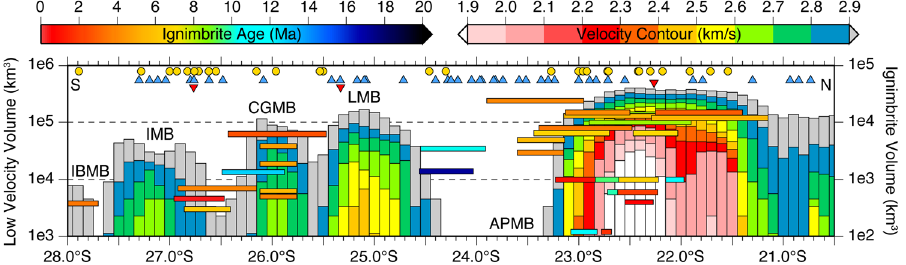
Figure 3. Along-strike spatial distribution of individual dated ignimbrite volumes (horizontal bars with volumes shown on right vertical axis; Freymuth et al . 11 and references therein), Holocene age volcanism (blue triangles), known ignimbrite eruption calderas (gold circles), INSAR measured vertical surface deformation centers 28 (inverted red triangles), compared against our seismic volumes enclosed by different velocity contours in 0.1° bins (with volumes shown on left vertical axis). The labels APMB (Altiplano-Puna Magma Body), LMB (Lazufre Magma Body), CGMB (Cerro Galan Magma Body), IMB (Incahuasi Magma Body), and IBMB (Incapillo-Bonete Magma Body) correspond to imaged magma reservoirs discussed in the text. This plot was made using the Generic Mapping Tool 61 , version 4.5.1